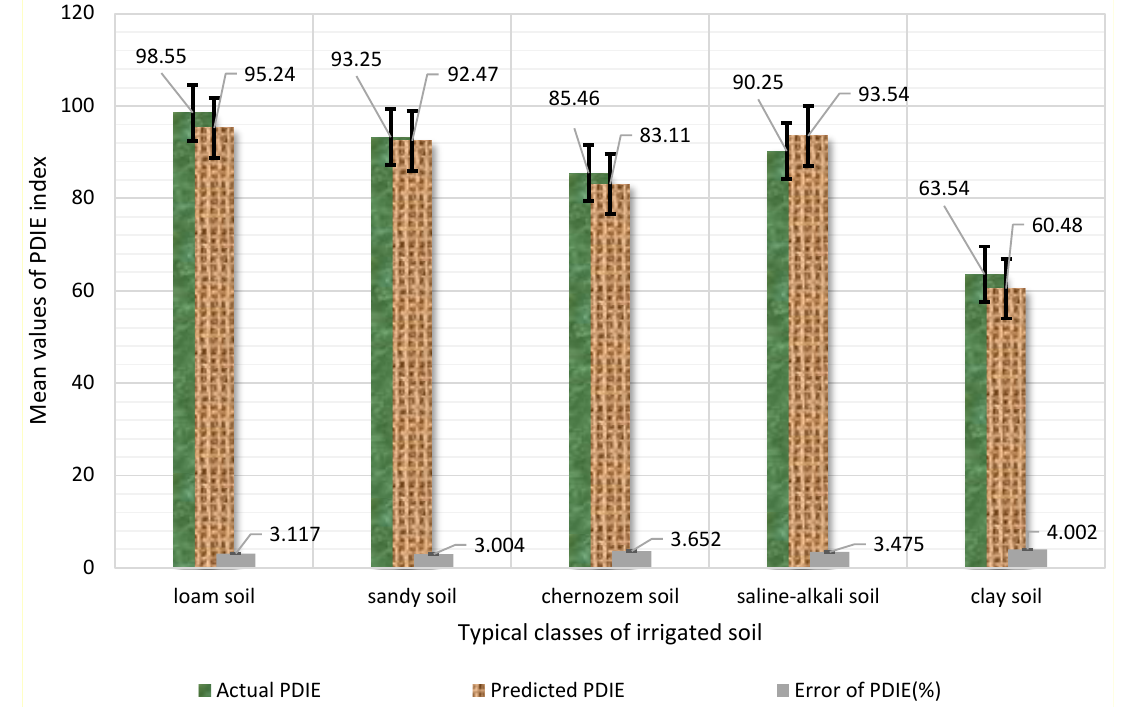
Figure 18. Comparison between the actual and predicted PDIE values in typical soil types.